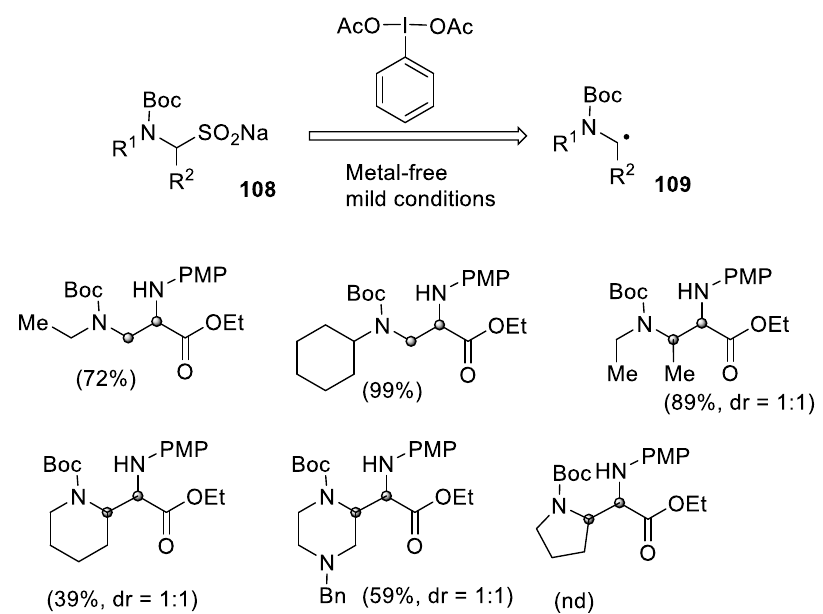
Scheme 18. PIDA- mediated generation of α -aminoalkyl radicals.